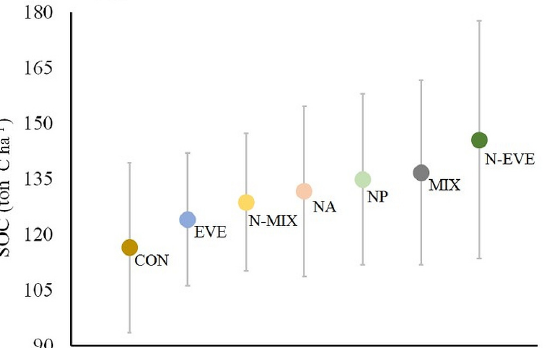
Figure A3. Soil organic carbon content (SOC) of the different Patagonian forest types in Argentina (see Table 1). The bars indicate the standard deviation.